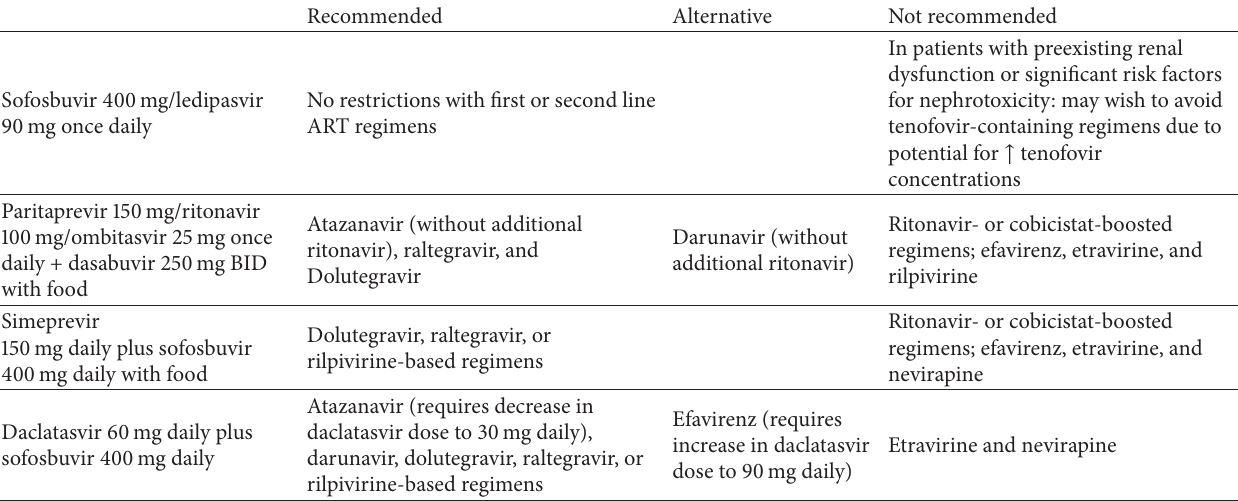
Table 5: Summary of antiretroviral regimen recommendations for patients who require concomitant HIV and hepatitis C